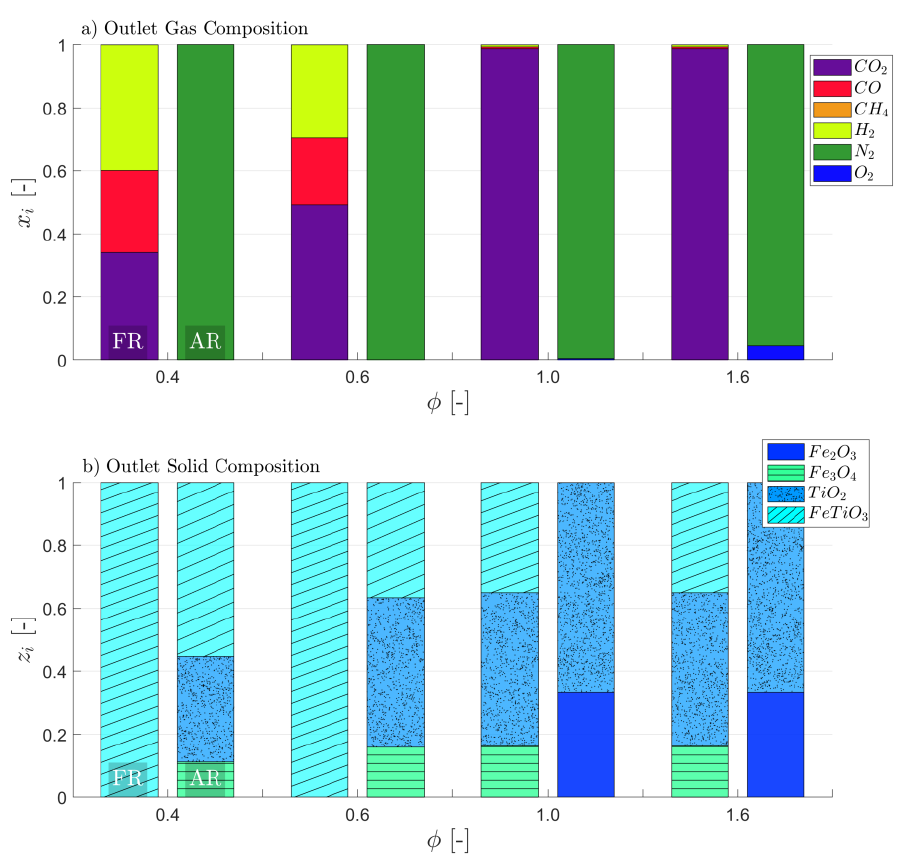
Figure 8. Simulation results for CLG operation through reducing λ . Dry molar gas composition ( a ) and molar solid composition ( b ) as a function of φ ( 𝑚̇ 𝑂𝐶 = 𝑐𝑜𝑛𝑠𝑡. ).